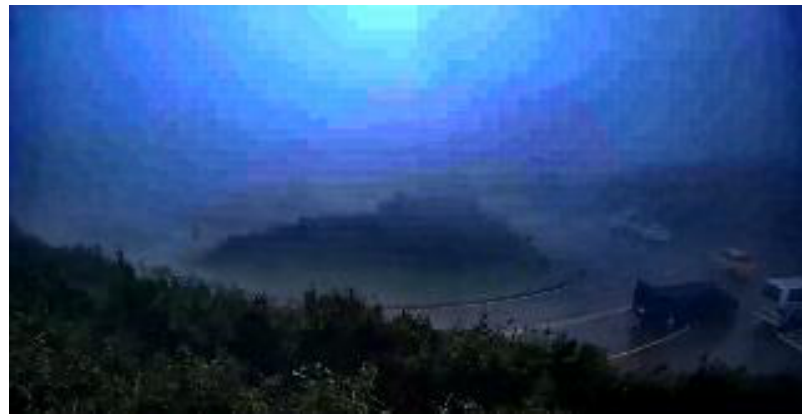
Figure 19. Haze scene: correction result.